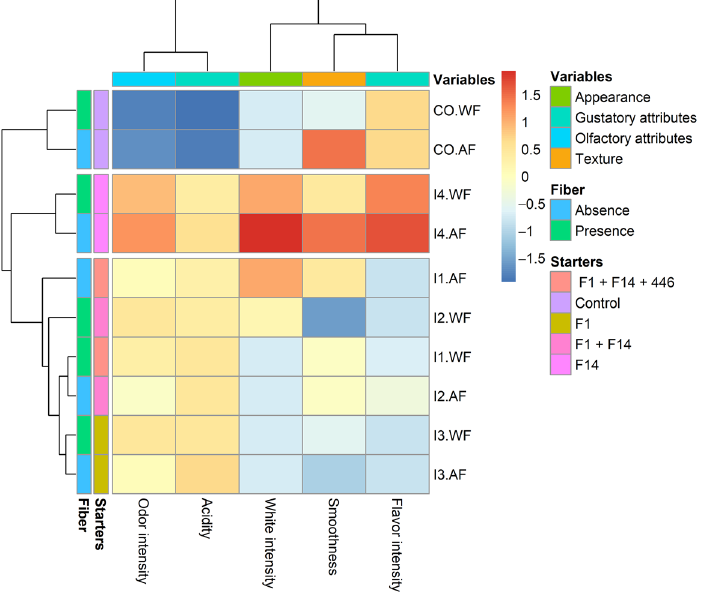
Figure 5. Pseudo-heat map showing the sensory attributes of the panelist’s evaluation. The appealing appearance was evaluated as color (white) intensity; texture characters were evaluated as smoothness; olfactory attributes referred to odor and aroma pleasantness; and gustatory attributes were evaluated as overall flavor intensity and acidity. “I1.”–“I4.” prefix represents the theses produced with milk fermented with different starters ( Lacticaseibacillus paracasei (F1), Lacticaseibacillus casei (F14), and Streptococcus thermophilus (446)), “CO.” prefix represents the negative control (without fermentation). “WF” and “AF” suffix means without and with the addition of dietary commercial fibers (5%, w / w ), respectively. Rows are clustered using Euclidean distance and McQuitty linkage (red line). The color scale shows the differences between the standardized data.